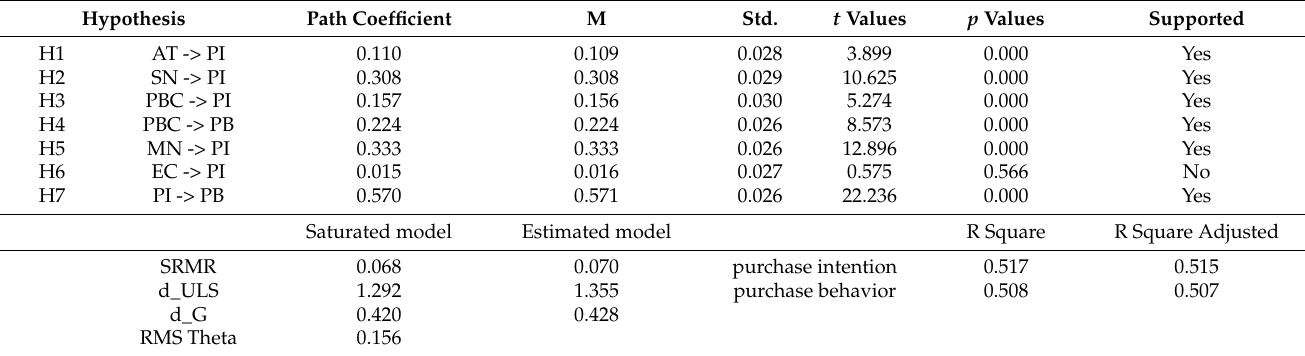
Table 5. Results of hypothesis